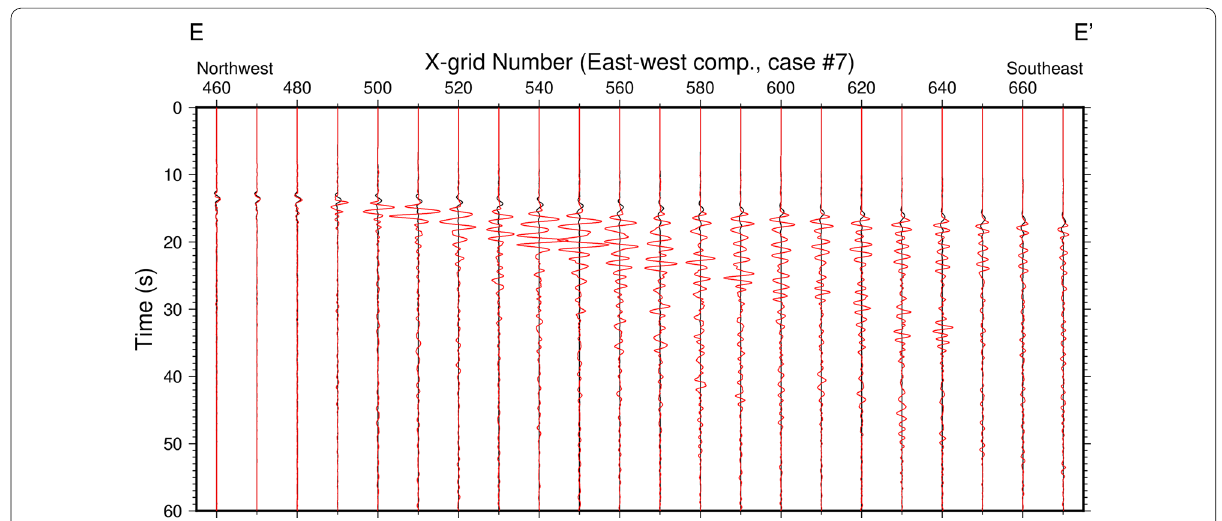
Fig. 14 Simulated velocity waveforms (0.1–2 Hz) along a profile line E–E’ across the Hakodate Plain. The east–west components for case #7 (Table 4) are displayed. Red: basin model, black: rock model. The geographical location of the profile line E–E’ is indicated in Fig.